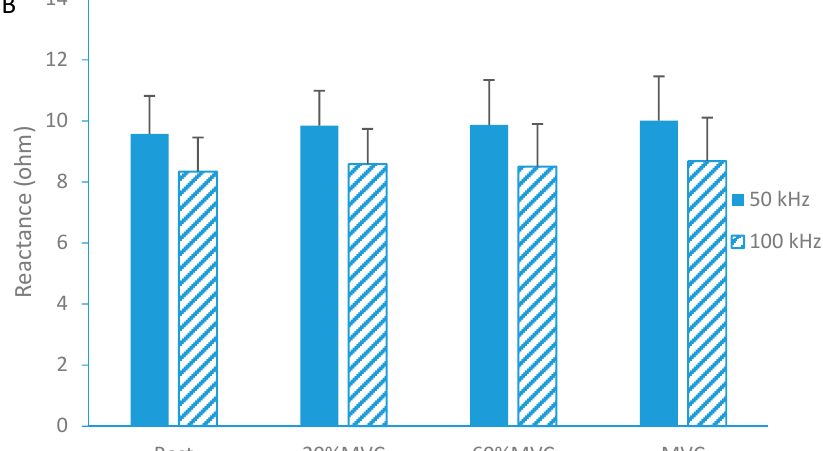
Figure 2. Resistance ( A ) and Reactance ( B ) at isometric contraction with two different frequencies (50 kHz and 100 kHz) (mean ± standard deviation, * indicates p < 0.05 between contraction levels).